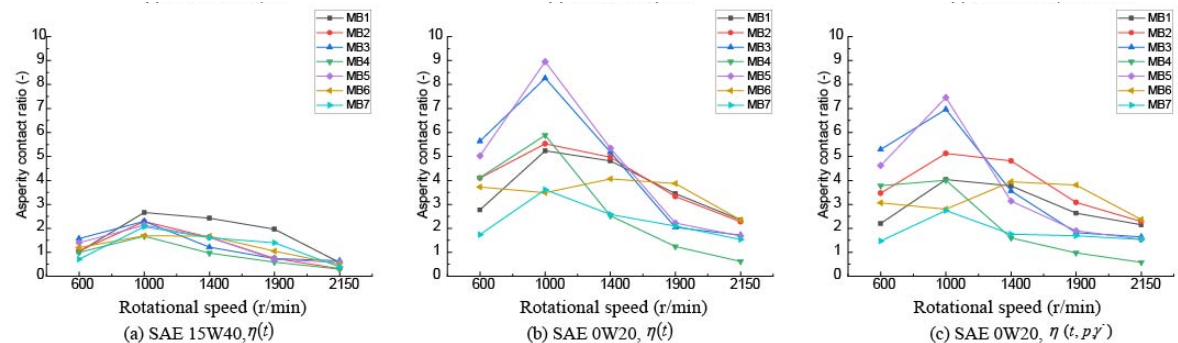
Figure 13. Asperity contact ratio of main bearings under typical working conditions.